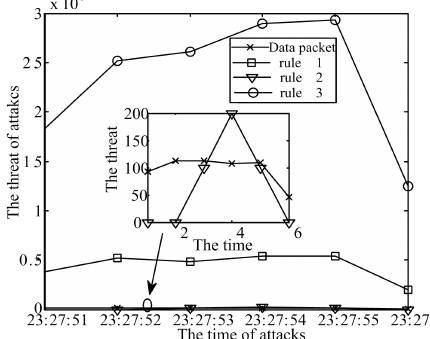
Figure 5: the network threat based on different source